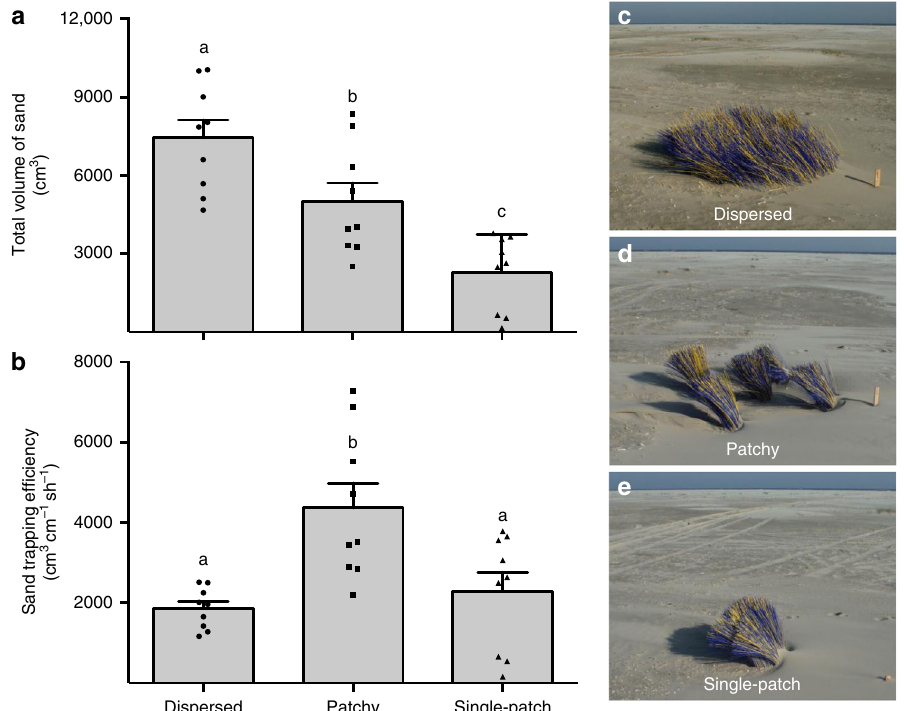
Fig. 4 Effect of spatial organization of shoot mimics on sand capture. a The total trapped sand volume was highest for the dispersed and lowest for the single-patch con fi guration. b Sand-trapping ef fi ciency (expressed as trapped sand volume divided by the distance between consecutive shoots) was more than two-fold higher in the patchy con fi guration. c – e depict the spatial mimic organization in the dispersed (Ballistic-like), patchy (Lévy-like) and single- patch (Brownian-like) con fi gurations, respectively. Experiment was set up in three experimental blocks and measured over three different time points. Error bars represent + s.e.m. ( N = 9, three experimental blocks, three repeated measures). Letters depict post hoc grouping ( p < 0.05). Source data are provided as a Source Data fi